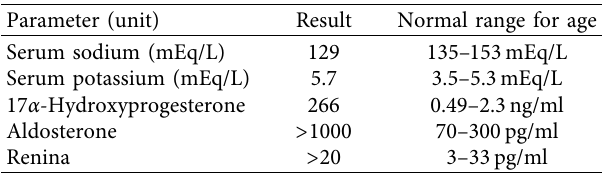
Table 1: Laboratory results of our patient at time of SW-CAH syndrome diagnosis.